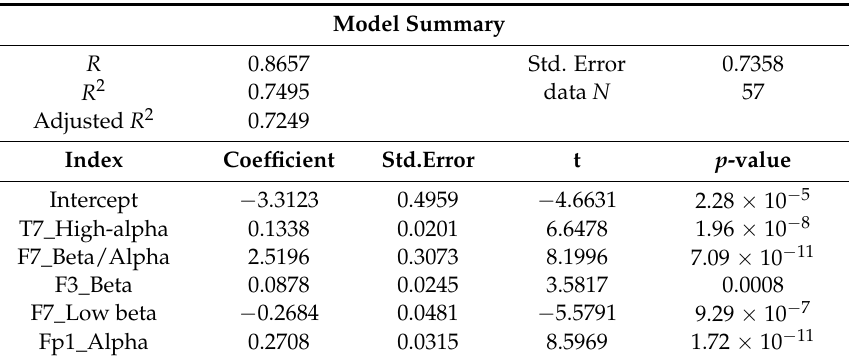
Table 1. Result of multiple regression 1 ( Yd ). Model